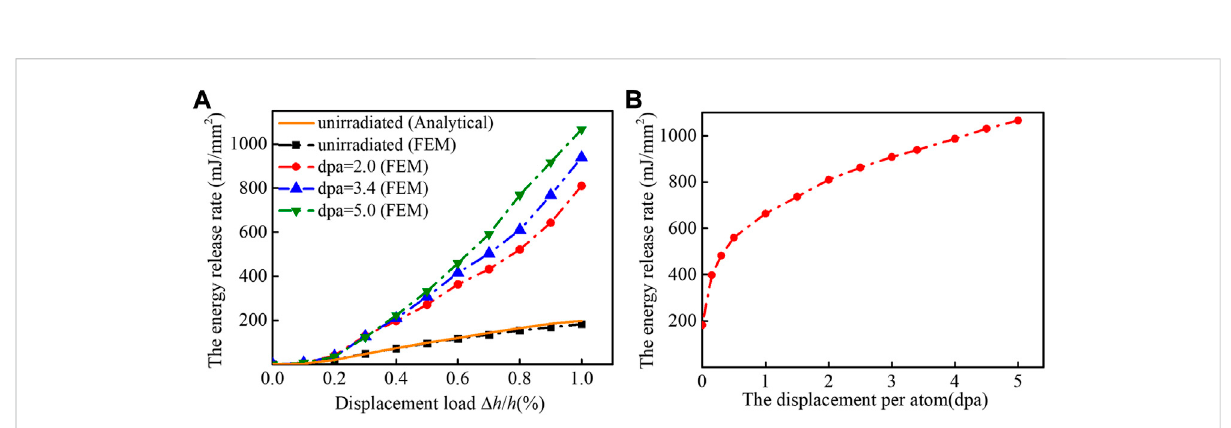
FIGURE 8 Variation of the energy release rate G with (A) deformation and (B) the displacement per atom